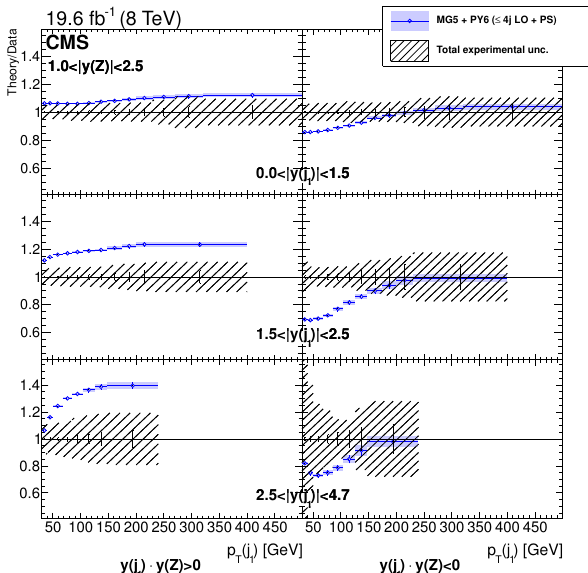
Figure 39 . Ratio to the measurement of the di(cid:11)erential cross section d 3 (cid:27)= d p T (j obtained with MadGraph 5 + pythia 6, with up to four jets at LO, for j y (Z) j 2 (1 ; 2 : 5). Left column corresponds to y (j ) y (Z) > 0 and right column to y (j 1 uncertainty is shown as a band around 1. Uncertainties in the predictions are shown on the ratio points and include the statistical uncertainty only.